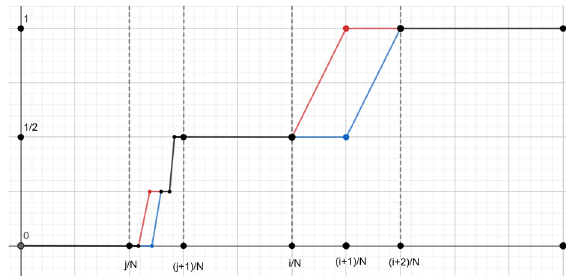
Figure 3: Case 1 – Sketch of piecewise linear approximations of F